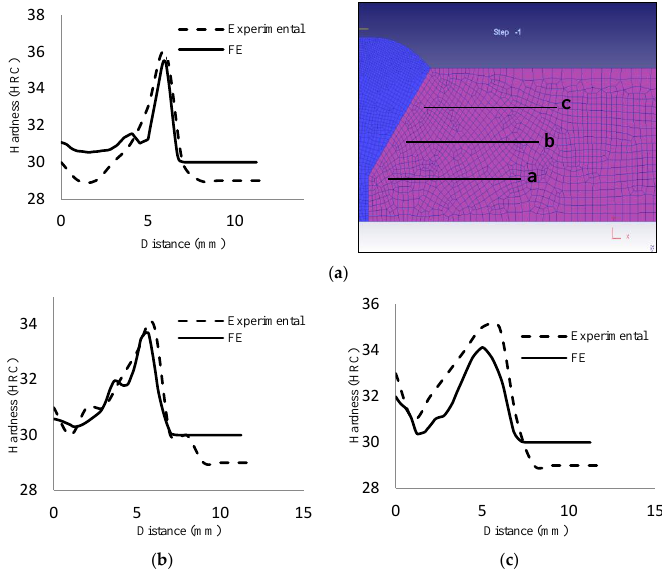
Figure 12. Distribution of hardness for ( a ) 3 mm, ( b ) 6 mm and ( c ) 9 mm above the weld root through the HAZ.